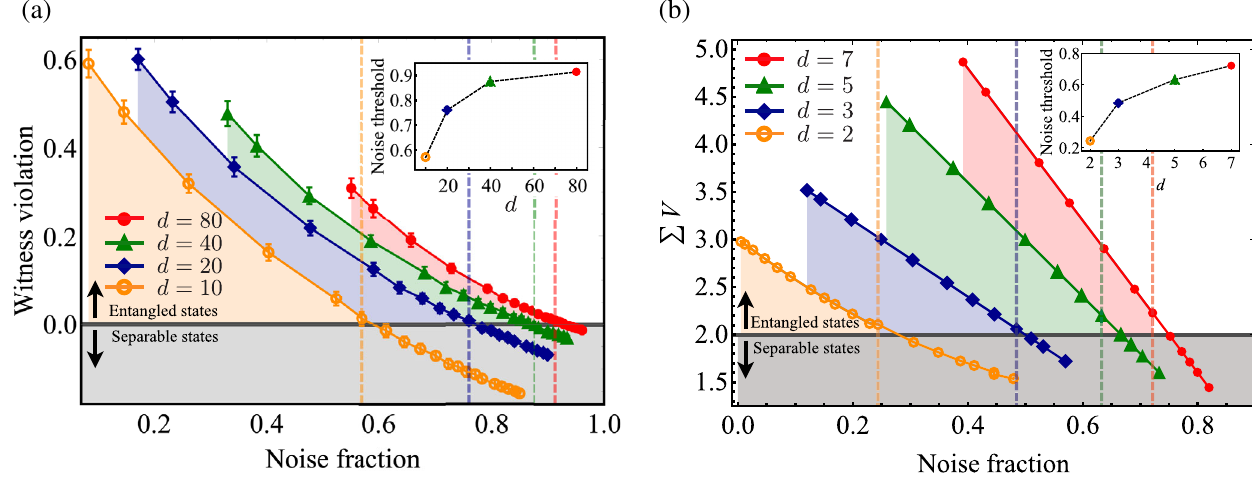
FIG. 3. Main results of our experimental demonstration of noise resistance for (a) energy-time entanglement and (b) OAM entanglement. Each plot depicts the violation strength of a suitably chosen entanglement witness against the noise fraction, i.e., the fraction of coincidence detections attributable to noise. In (a), the principal competition in achieving noise resistance is clearly visible. As the dimensionality is increased through fine-graining (pathway I), more noise is induced (and thus the curves move to the right), while a higher noise resilience is achieved (thus the noise threshold also moves to the right). Plot (b) is qualitatively different, as it explores pathway II. Instead of fine-graining, more modes are included in the analysis which allow for an increased number of mutual unbiased bases to be measured and thus also show a higher noise threshold with increasing dimension. The error bars correspond to 3 standard deviations of the mean, calculated by propagating the Poissonian error in the photon-counting rates via a Monte Carlo simulation; see Supplemental Material, Sec. IV [47]. In (b), the error bars are smaller than the data